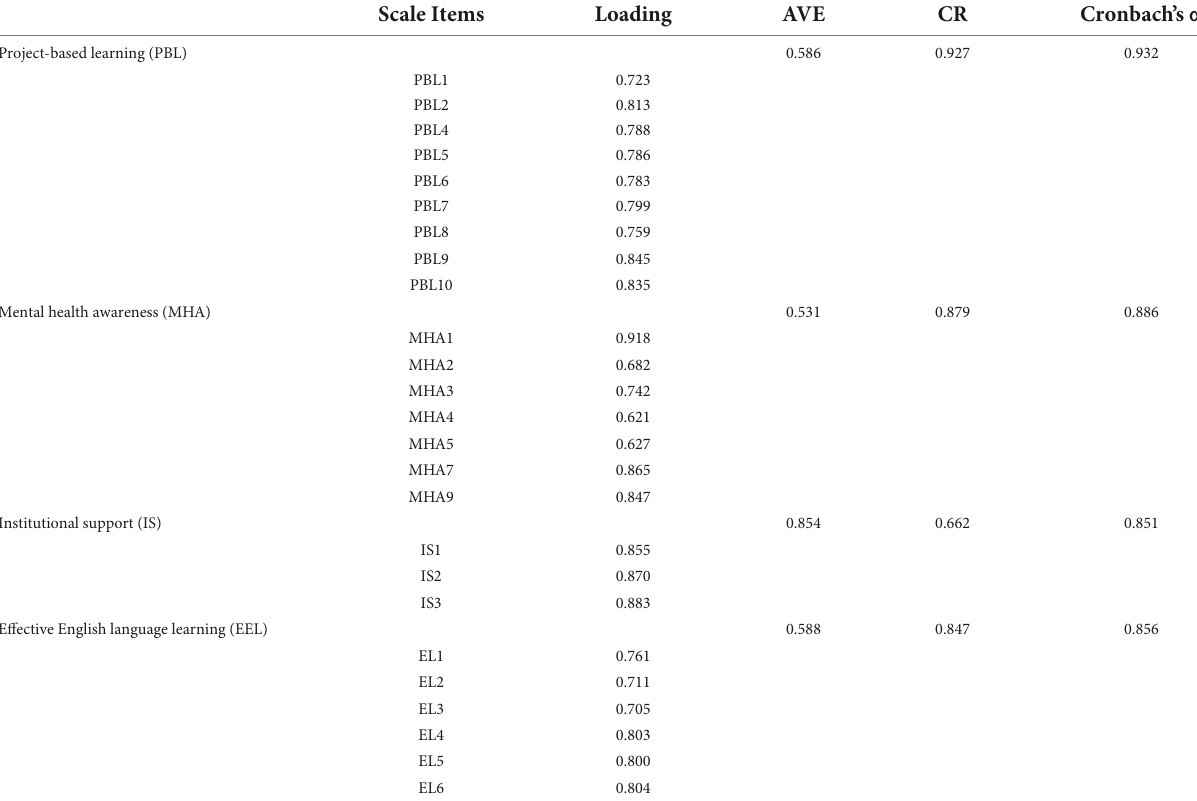
TABLE 2 Convergent validity, reliability and factor loadings.